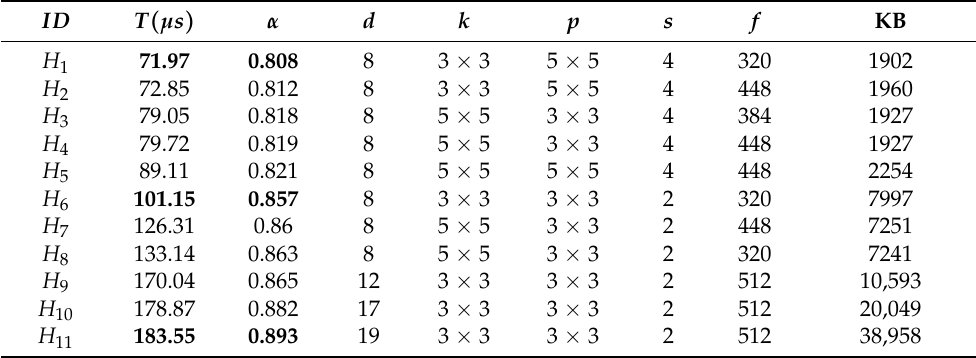
Table 6. Pareto and δδδ -Pareto optimal CNNs for CIFAR-10 where the example user requirements